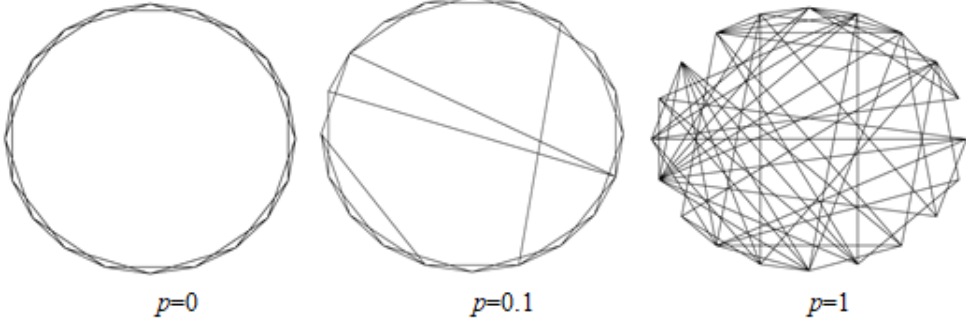
Figure 1. Forming different network structures based on different randomness p